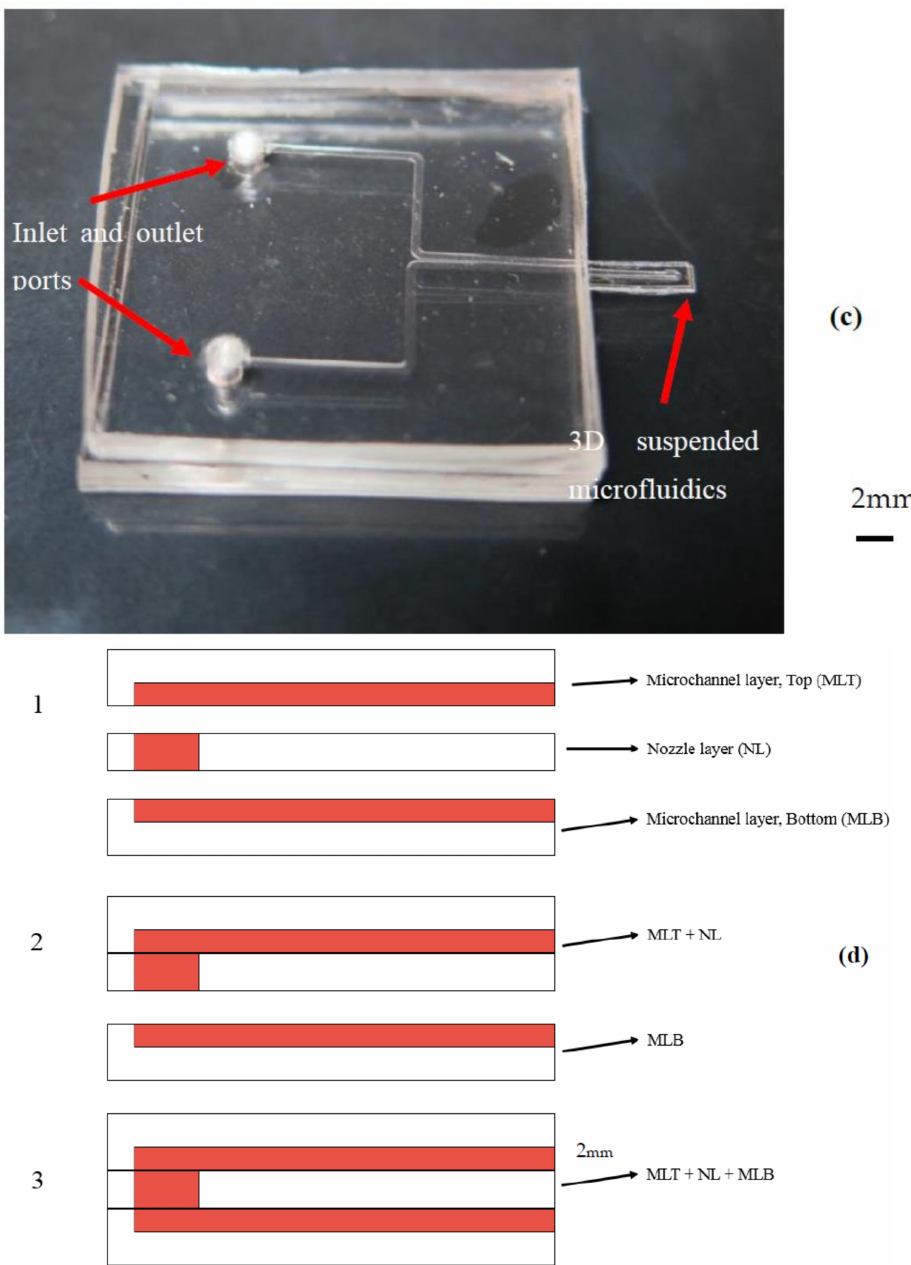
Figure 6. ( a ) PDMS layers fabricated on glass slides; ( b ) PDMS layers bonded together between glass slides; ( c ) final 3D suspended microfluidics; ( d ) schematic view of bonding sequence of the main layers (MLT, NL, and MLB) to create SPMF 3